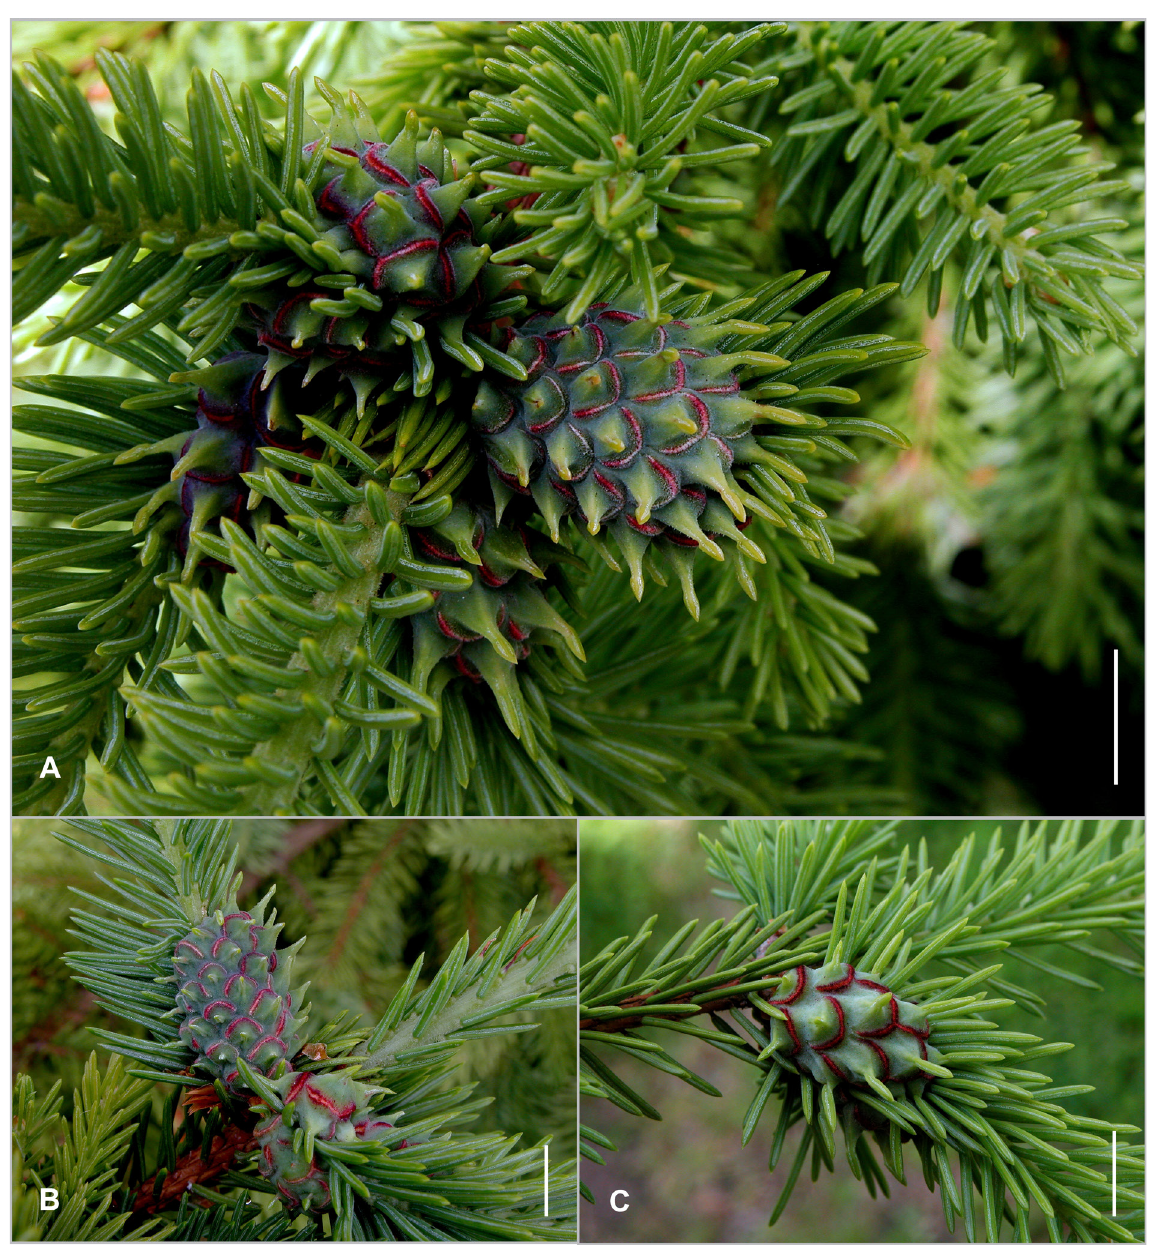
Fig. 17. Adelges (Sacciphantes) abietis (Linnaeus, 1758), galls on Picea abies . A–B . Almost full-grown. C . Half-grown. Colouration typical for galls growing in open sites. Scale bars: 10